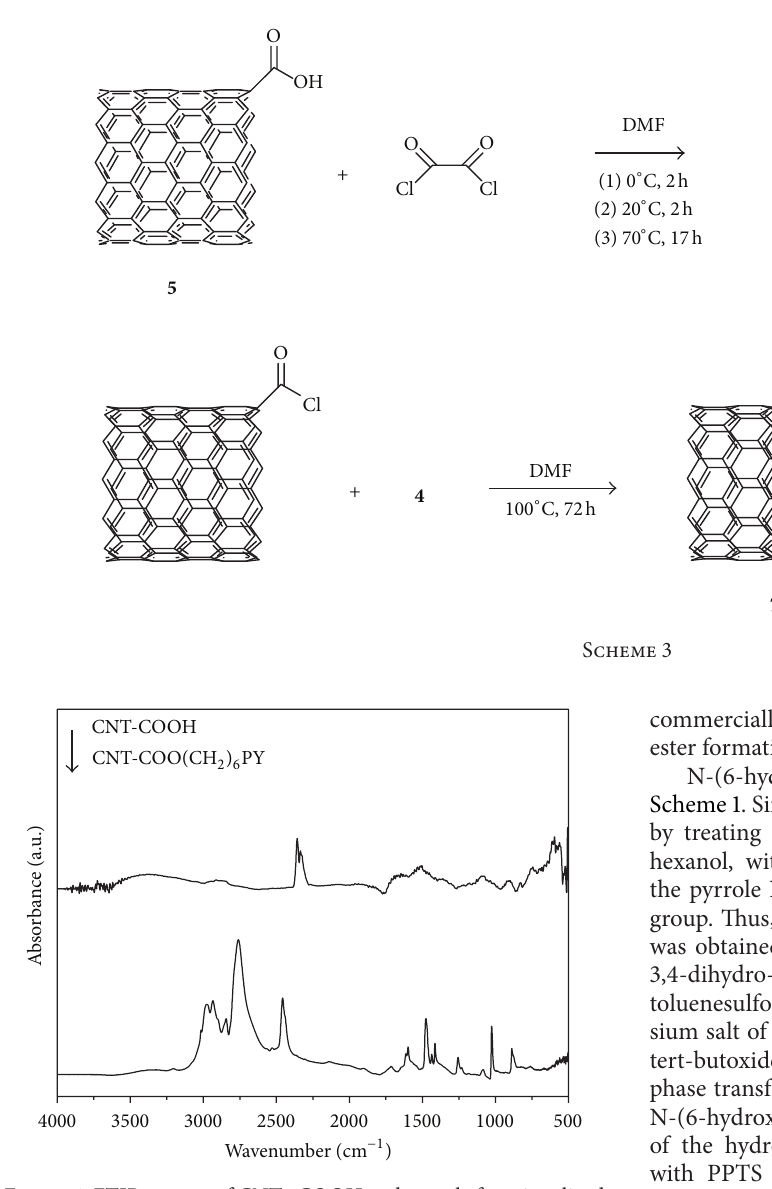
Figure 1: FTIR spectra of CNTs-COOH and pyrrole functionalized